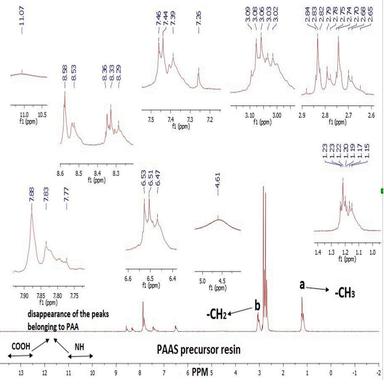
The 1 H NMR spectra of PAAS.